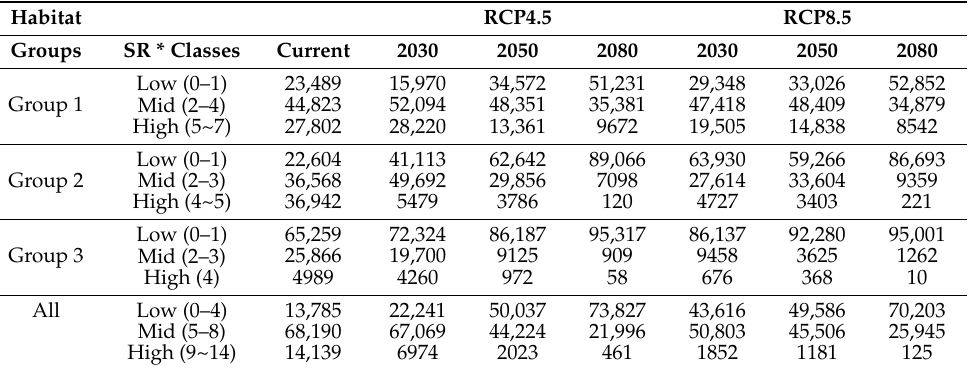
Table 6. Areas of the species richness classes of amphibians in South Korea from different habitat groups (unit: km 2 ).